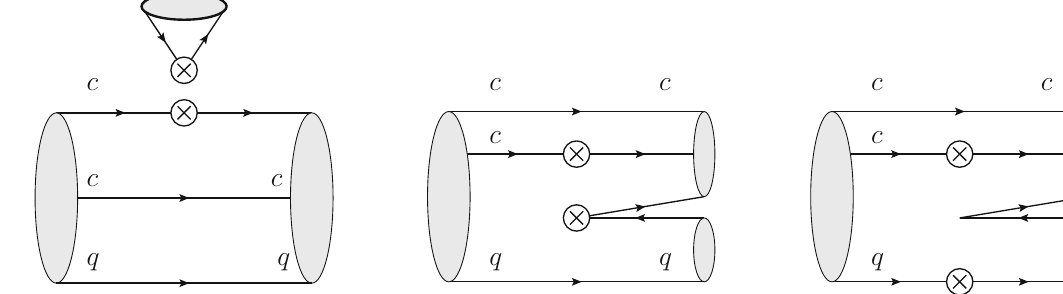
Fig. 4 The Feynman diagrams for (cid:2) cc and (cid:5) cc decays into a charmed baryon and a light